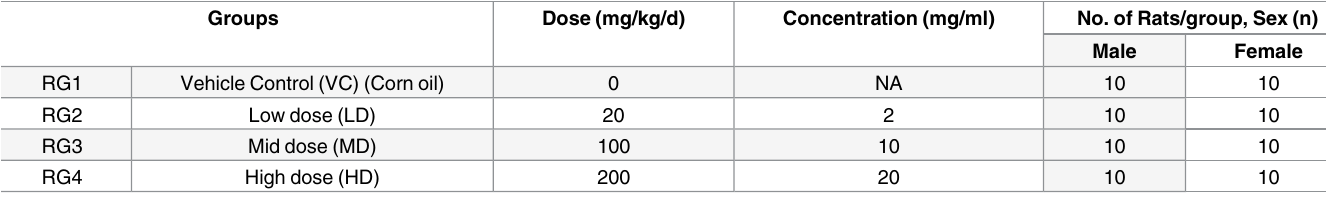
Table 6. Dosage groups for reproduction/developmental toxicity study in Wistar rats.